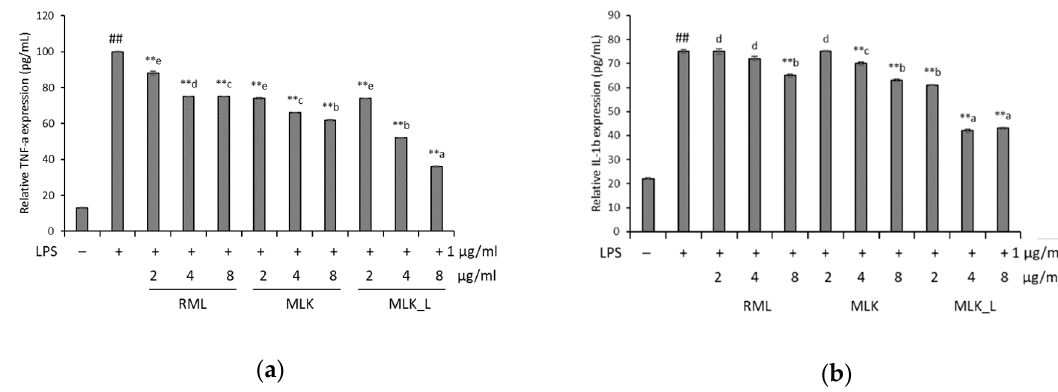
Figure 3. Relative expression levels of tumor necrosis factor (TNF)- α ( a ) and IL-1b ( b ) in LPS-induced RAW264.7 cells. Data were presented as the mean ± standard deviation (SD) of three independent experiments. Means sharing the same alphabet in superscript within each sample are not significantly different at p < 0.05 by ANOVA and Duncan’s multiple range test. * p < 0.05, ** p < 0.01 vs. LPS, and # p < 0.05, ## p < 0.01 vs. the LPS-stimulated group.